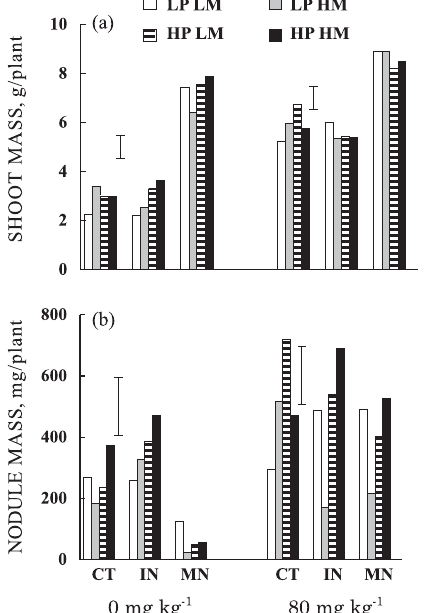
Figure 1. Shoot (a) and nodule (b) mass of common bean plants grown at two P levels applied to the soil (0 and 80 mg kg -1 ) and three N sources (CT control without N, IN inoculated with rhizobia, MN mineral N), originating from seeds with different concentrations of P and Mo (LP low P, HP high P, LM low Mo, HM high Mo); vertical bars represent the least significant difference by the Tukey test at 0.05 level, and compare seed treatments within each N source and soil P